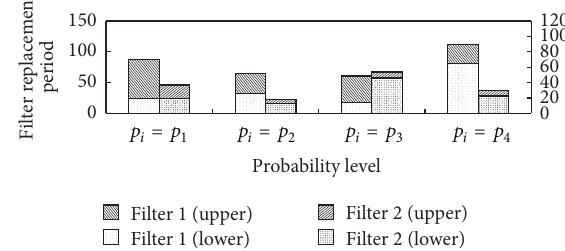
Figure 10: Filter replacement periods for Scenario 6 under high contaminant ingression/generation level.